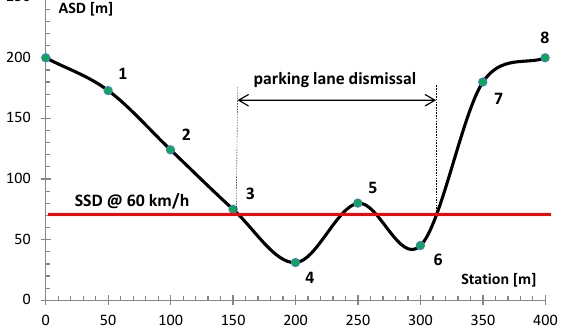
Figure 9. ASD evaluated for the case study, and comparison with SSD @ 60